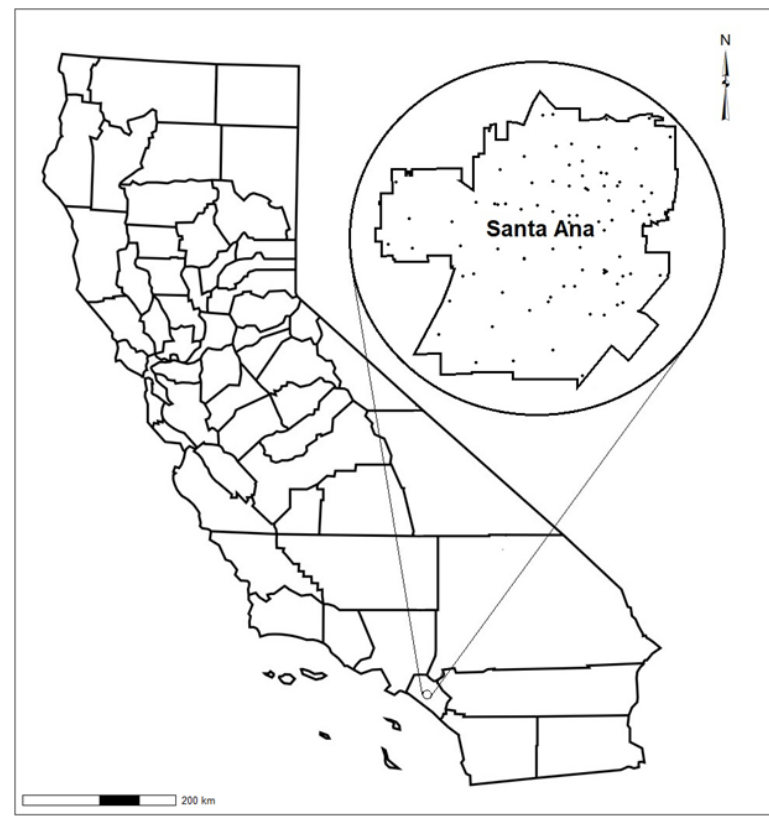
Figure 1. Study location and isotope samples sites.